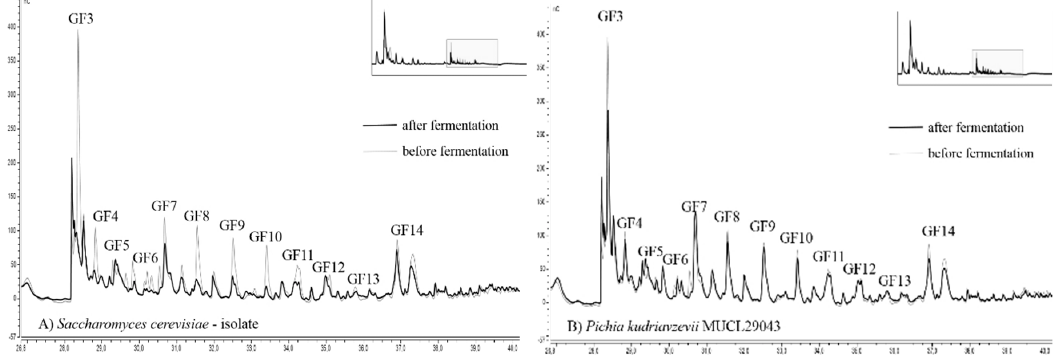
Figure 4. HPAEC (high pressure anion-exchange chromatography) fingerprint of fructans fermented by ( A ) Saccharomyces cerevisiae –sourdough isolate, and ( B ) Pichia kudriavzevii MUCL 29043. Chromatograms showing the initial fructan profile (grey line) and the alteration after 8 h and 15 min of fermentation at 25 °C (black line) and are illustrated for both strains. G (glucose) and F (fructose).